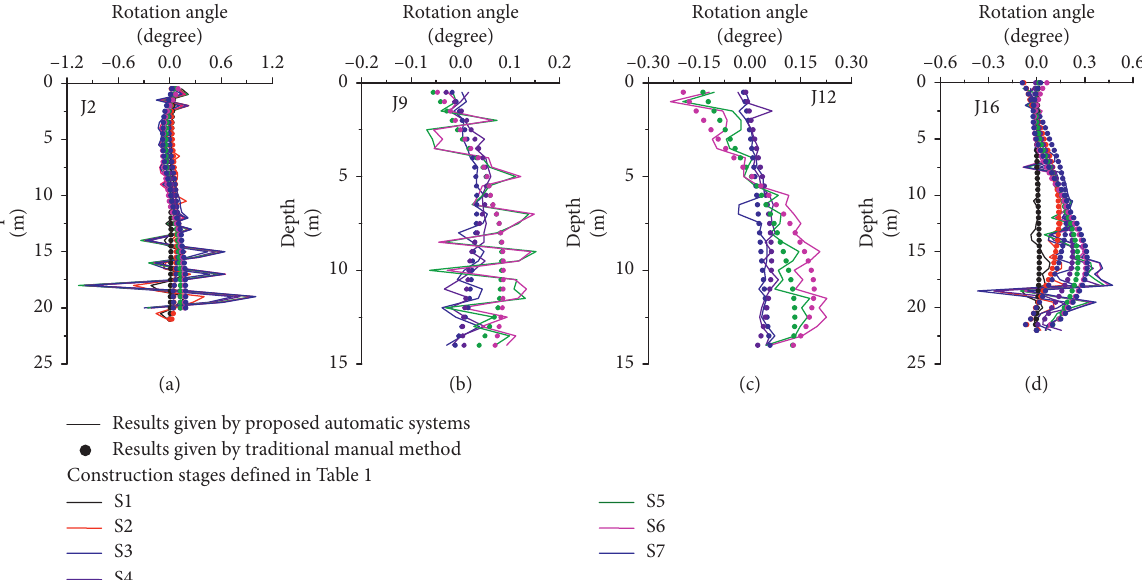
Figure 9: Comparison of the rotation angle between the proposed automated system and traditional manual method at several typical construction stages in the studied